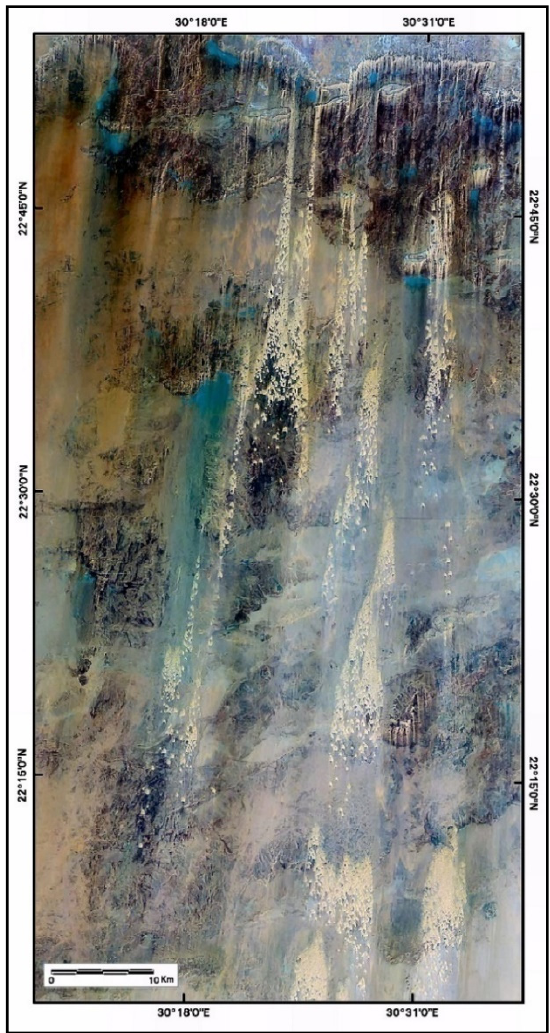
Figure 5. Barchans organized in Barchanoid belts in the extreme south of the southern section of Ghard Abu Moharik, near to the Sudanese border. Source: Landsat TM image.